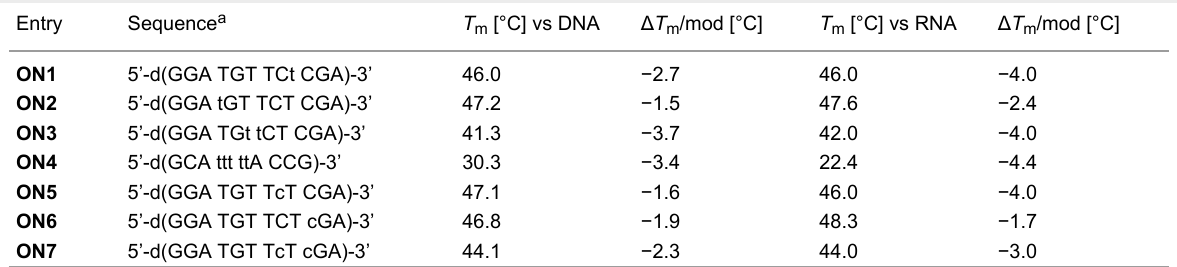
Table 1: T m and Δ T m /mod data from UV-melting curves (260 nm) of ON1 – 7 in duplexes with complementary DNA and